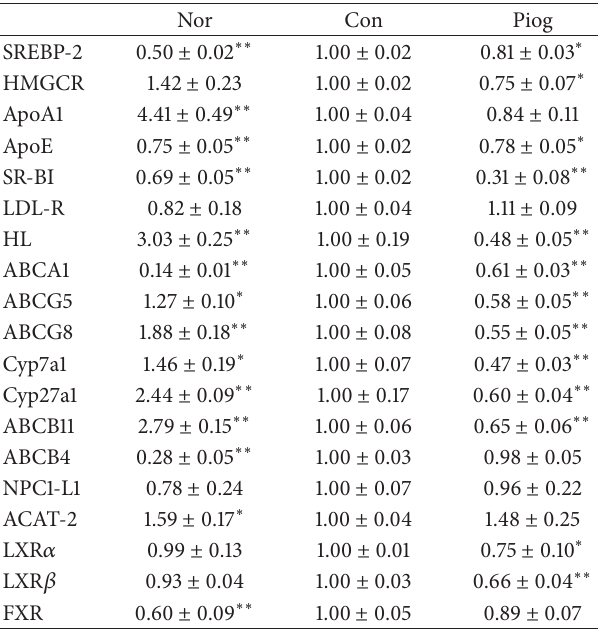
Table 2: Effects of pioglitazone on the expression of cholesterol metabolism related genes in the liver of KKAy